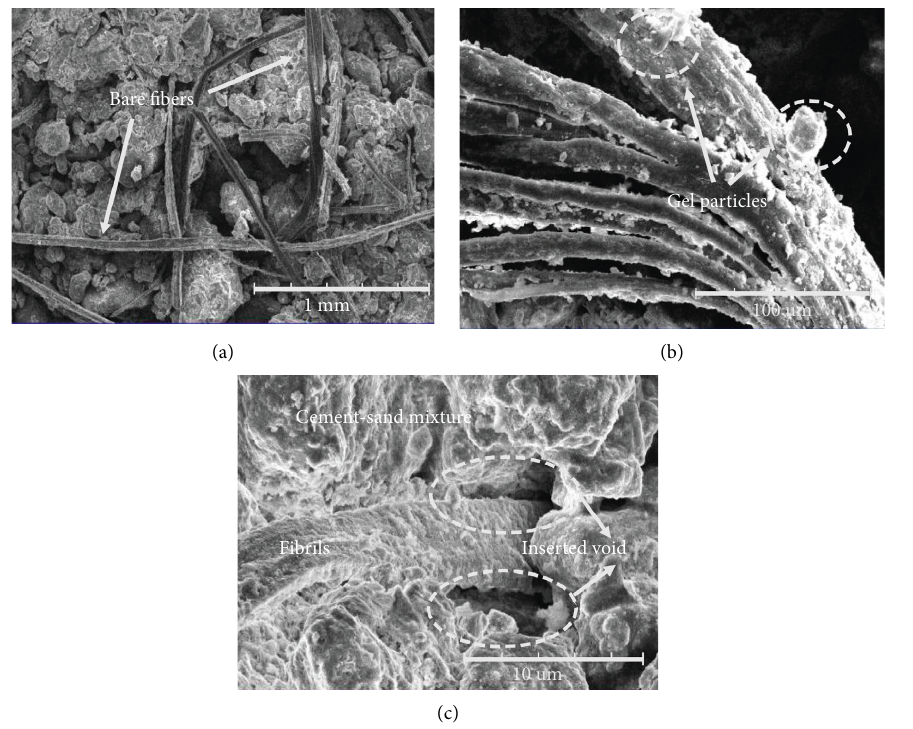
Figure 5: Micromorphology of the cement–fiber–sandy soil mixture (a) 50 × (b) 100 × (c) 500 ×